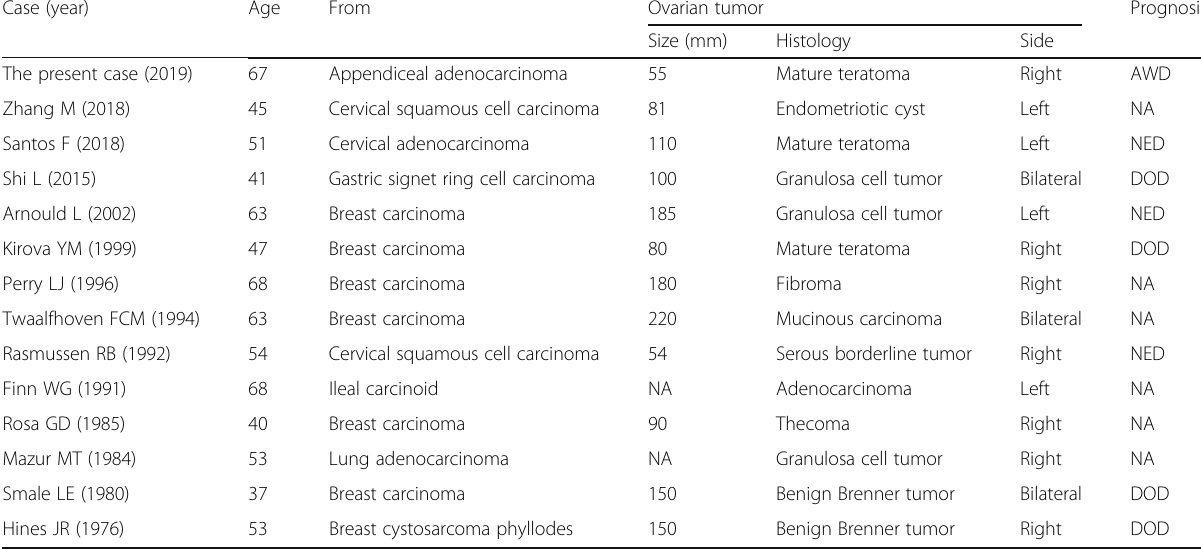
Table 1 Tumor-to-tumor metastasis to ovarian tumor Case